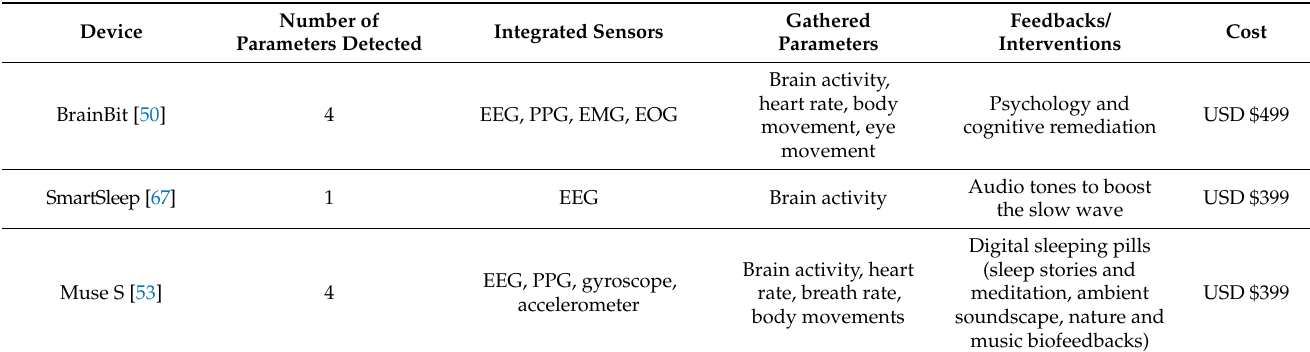
Table 2. Comparison between the devices discussed above from the point of view of number and typology of the integrated sensors, gathered parameters, and